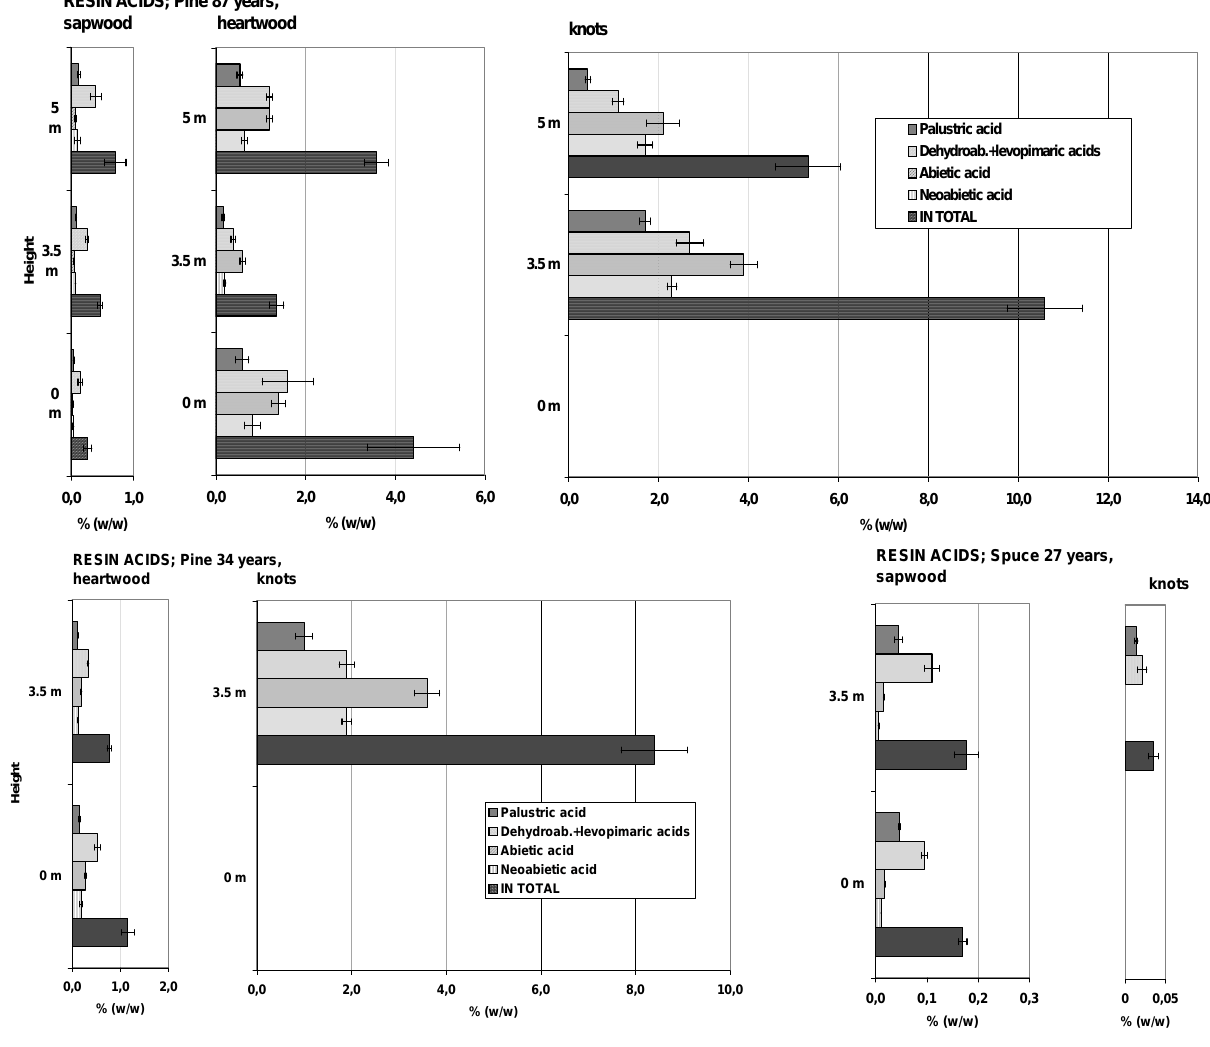
Figure 2. Resin acid analyses of Norwegian pine and spruce; content (%, w/w) and